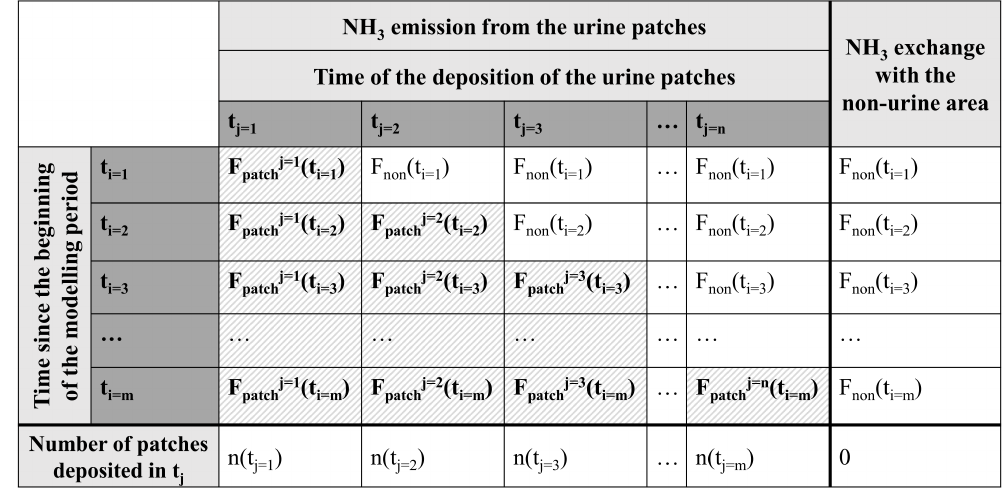
Figure 5. Schematic for the temporal development of NH 3 fluxes (in every i th time step, t i ) as derived by GAG_field. F j the NH 3 flux from the urine patches deposited in the j th time step ( t j ) , and F non ( t i ) stands for the NH 3 flux from the non-urine area. The bottom row shows how many urine patches were deposited in the given j th time step ( n ( t j )) . Fluxes with striped background are calculated by GAG_patch, and the fluxes with clear background are calculated by a modified version of GAG_patch for non-urine area (explained in the